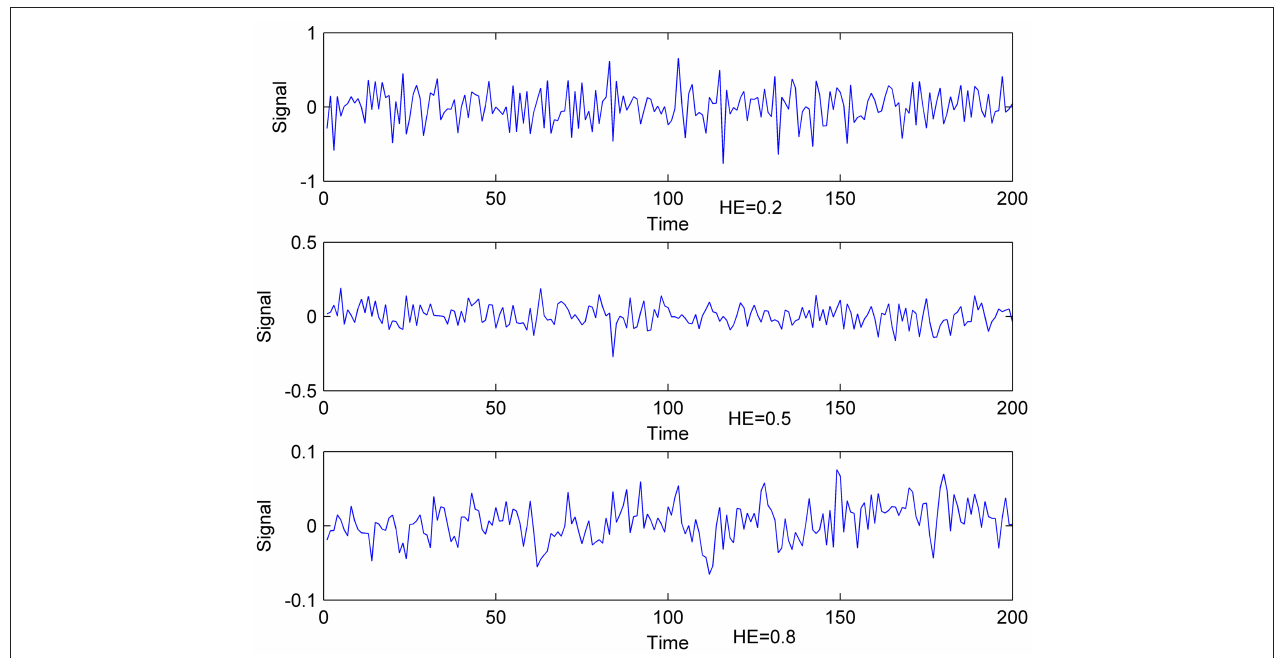
FIGURE 1 | Exemplificative illustrations of time-series with different HE. Lower : time- series with HE of 0.8; Middle : time-series with HE of 0.5; Upper : time-series with HE of 0.2.